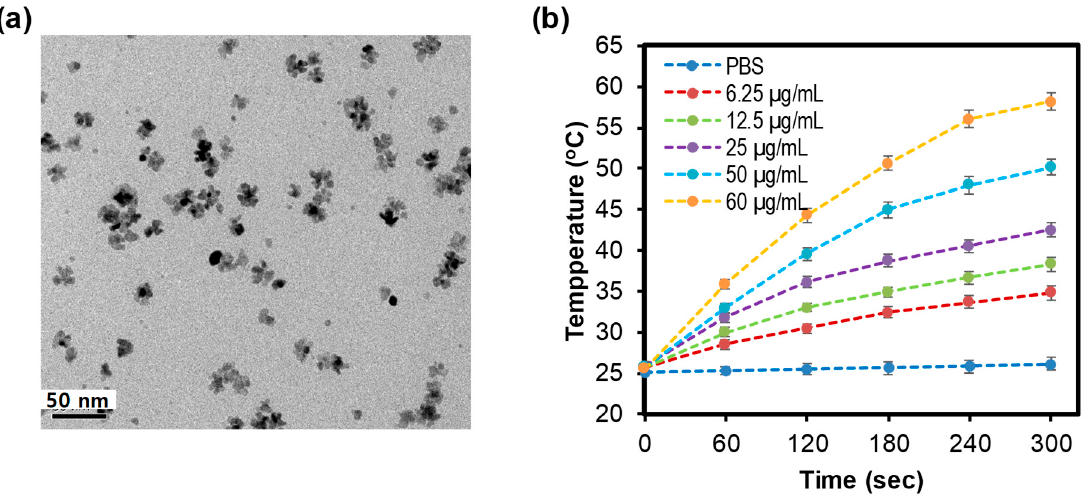
Figure 1. ( a ) Transmission electron microscopic (TEM) of palladiums nanoparticles (PdNPs), ( b ) Heating curve of PdNPs under irradiation (0.5 W/cm 2 , 5 min).